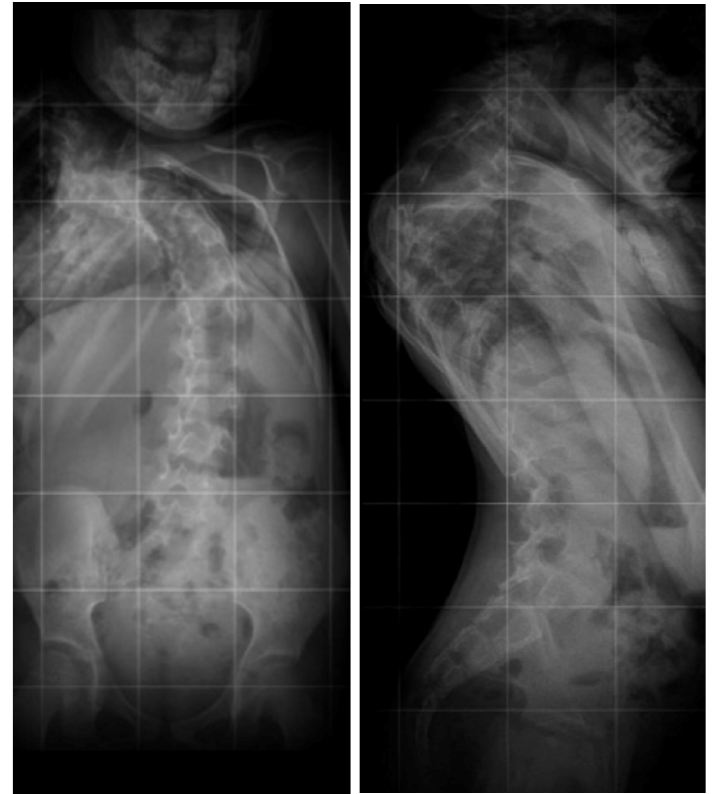
Figure 1. Standing X-Rays of the five-year-old girl before surgical treatment.